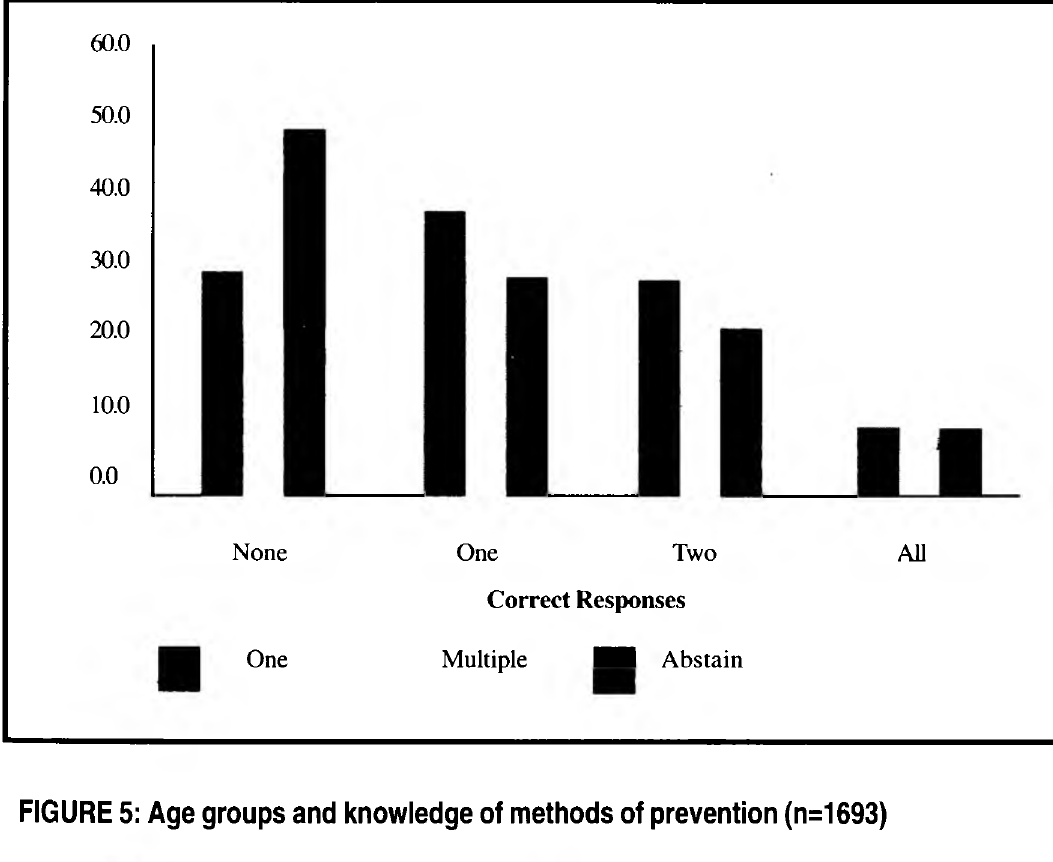
FIGURE 4: Knowledge regarding signs and symptoms of sexually transmitted infections and number of current partners (n=1686)